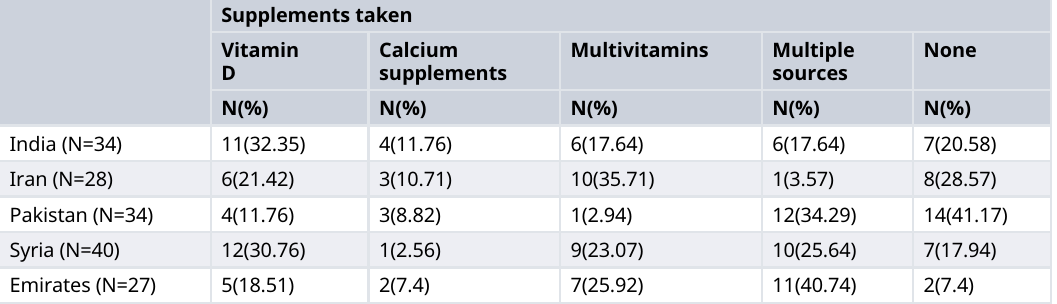
Table 6. Nationality of study participants [top 5=163 (67%)] and vitamin